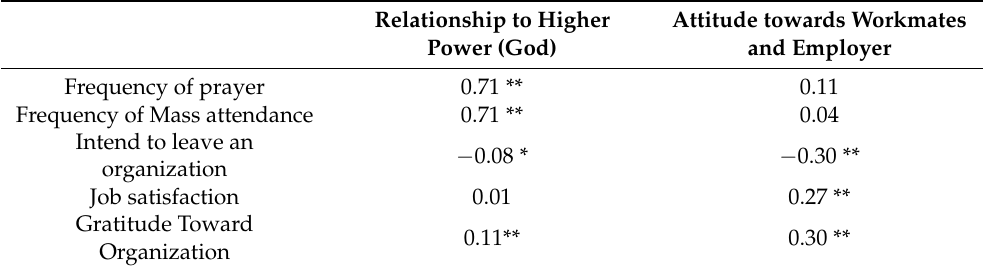
Table 5. Pearson correlations between the factors constituting the employee spirituality scale and the measures being indicators of the theoretical consistency employee spirituality scale ( N = 804). Relationship to Higher Power